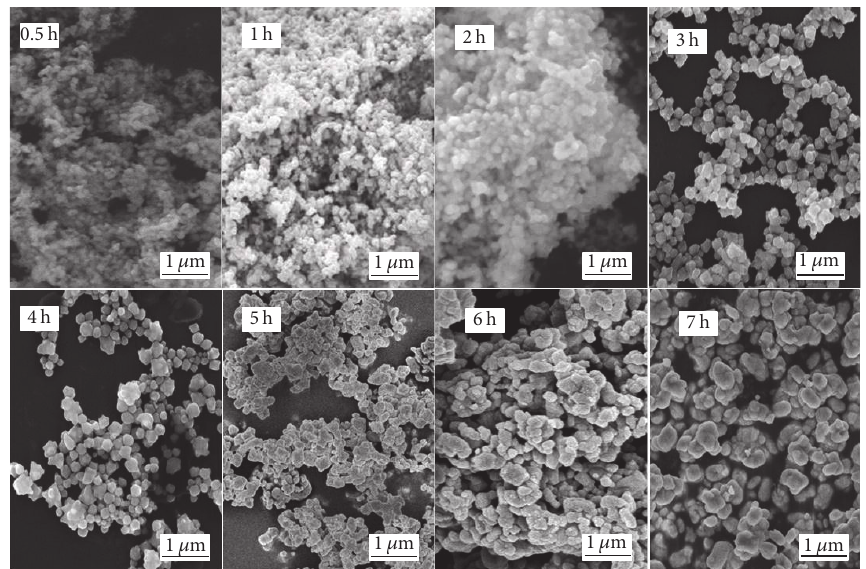
Figure 8: Co particle size of sample (a) changes with different heat retaining times (450 ∘ C).